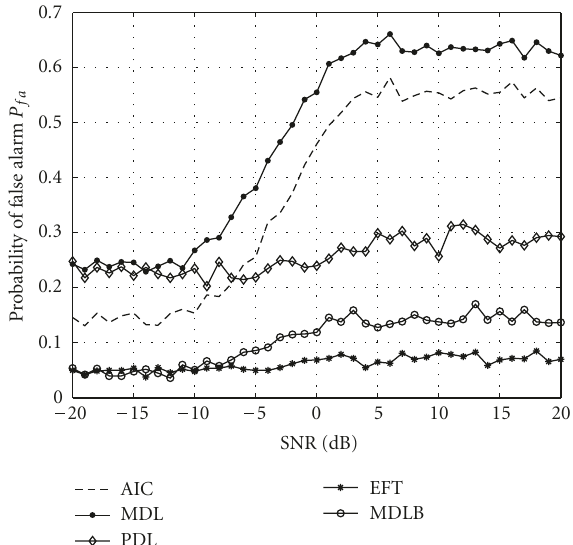
Figure 4: Comparison of the probability of false alarm for the EFT (predefined P fa = 10%), the MDL, the AIC, the PDL, and the MDLB.